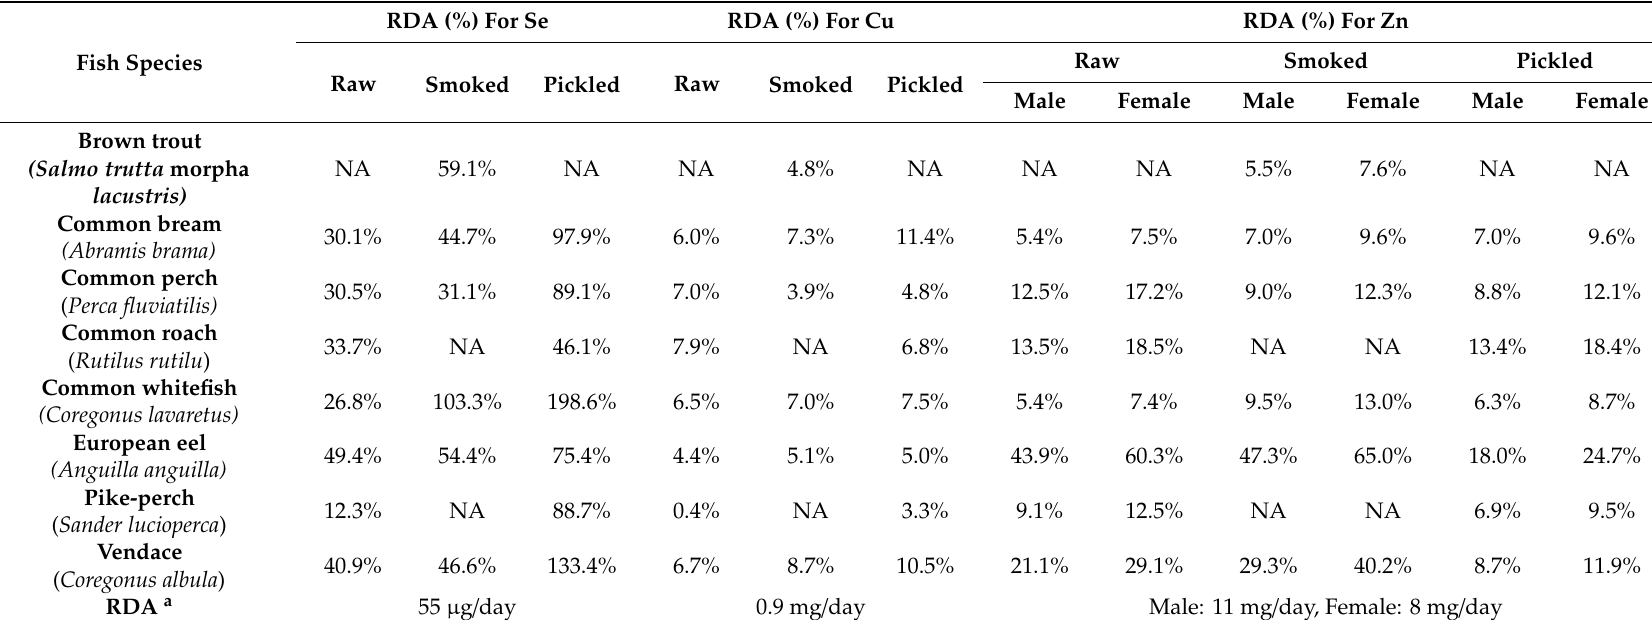
Table 1. Recommended dietary allowance (%) of Se, Cu and Zn after the consumption of 150 g of fish product. RDA (%) For Se RDA (%) For Cu RDA (%) For Zn Raw Smoked Pickled Fish Species Raw Pickled Raw Smoked Pickled Male Male Male